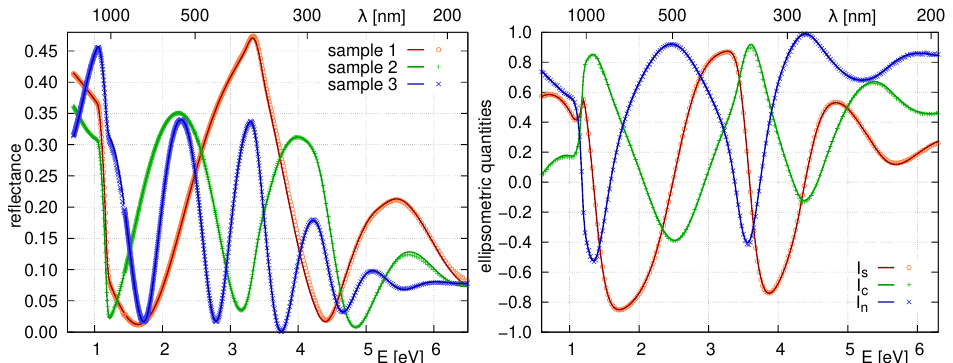
Figure 12. The spectral dependencies of reflectance for all three samples ( left ) and the ellipsometric quantities for sample 2 at incidence angle 70 ◦ ( right ). The points represent the experimental values while the lines represent the theoretical